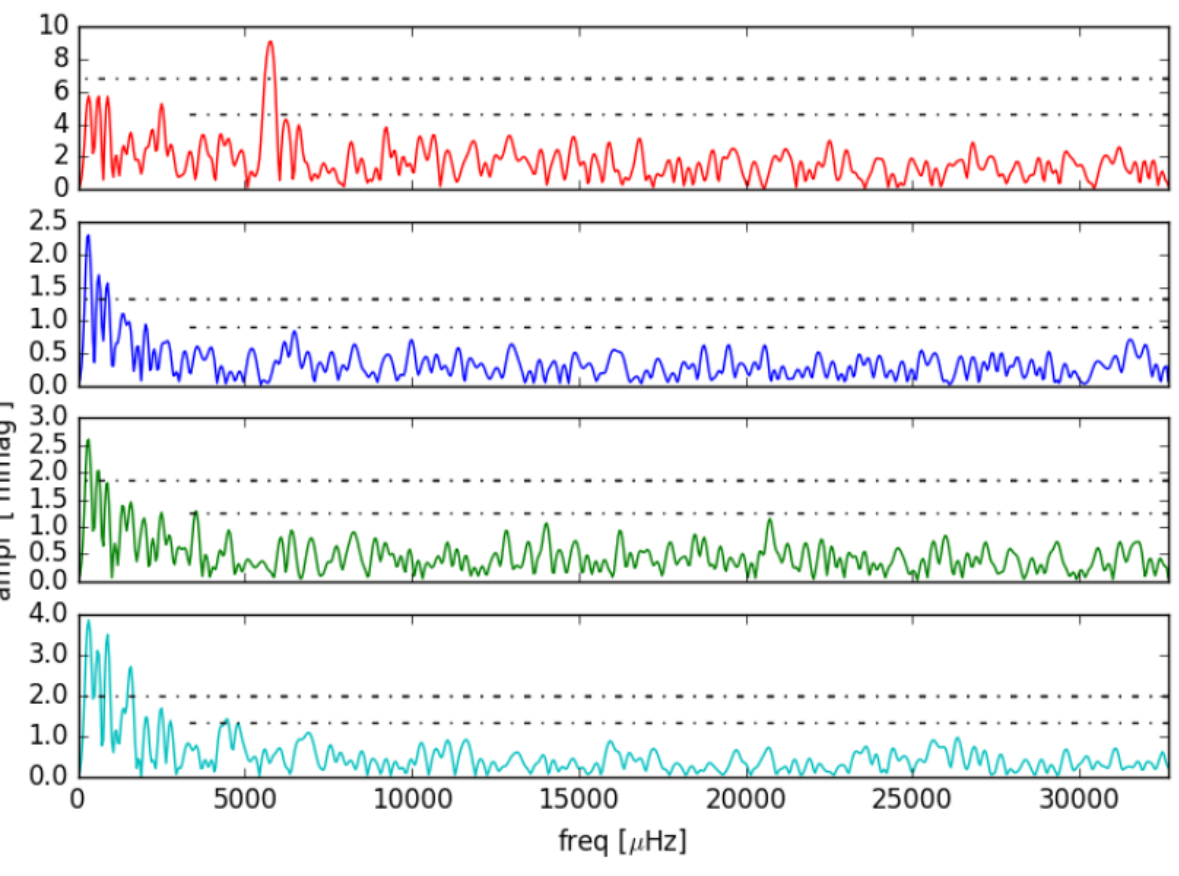
Figure 2. Periodograms of the light curves of Figure 1 after detrending, with fluxes of the faintest comparison stars summed together (bottom panel). The main target (top) is depicted in red. The 2.7 σ and 4 σ significance levels are indicated by dashed-dotted lines. A clear pulsation peak is visible in the periodogram of the target, at 5789.6 µHz equivalent to a period of 172 seconds.